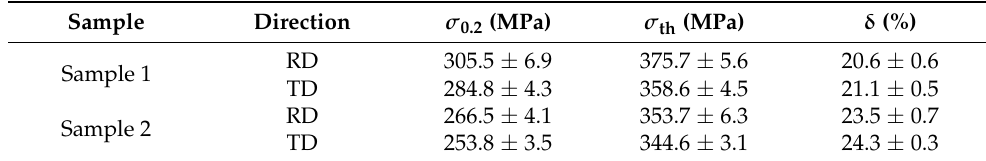
Table 6. Mechanical tensile properties of two T3-tempered samples.